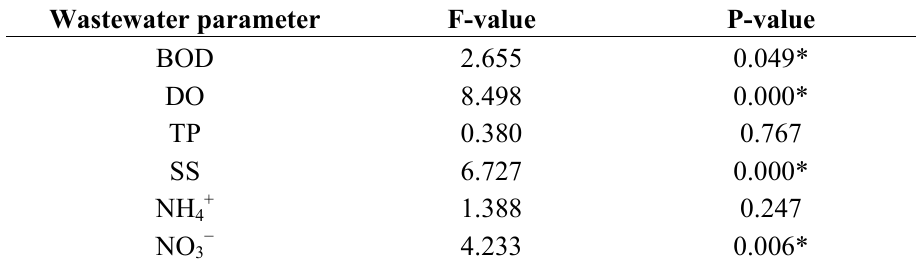
Table 7. Results of one-way Analysis of Variance (ANOVA) assessing the waste removal quantity of each wastewater parameter among the four study SSF CWs. * p < 0.05.